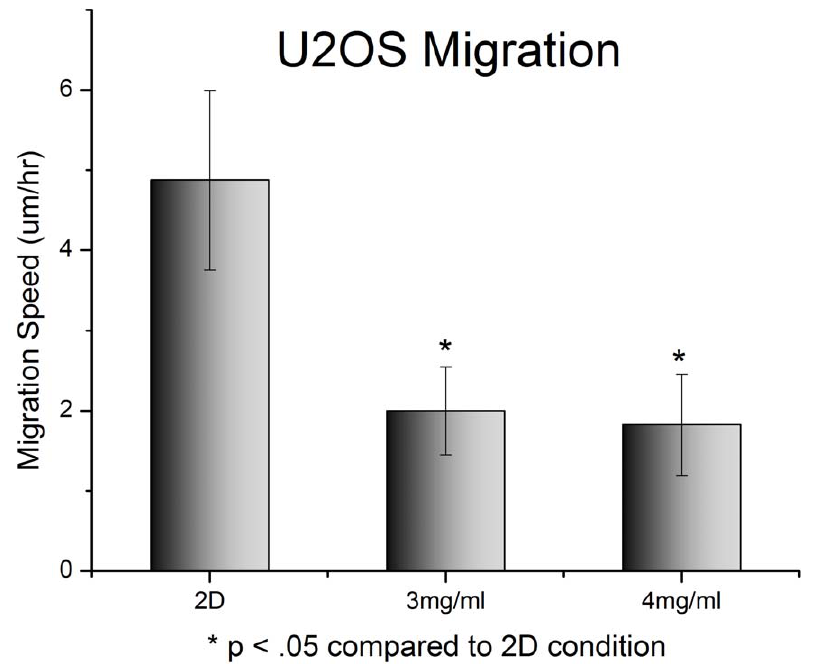
Figure 6. Migration of U2OS cells on standard 2D tissue culture plastic compared to 3D collagen gels. Cells were plated, and then immediately underwent timelapse imaging for 12 hours. Data here is the average speed of the cells over the course of the imaging sequence. Cell tracking was done using Imaris H software suite (Bitplane Inc., St. Paul, MN), with additional data processing done in MatLab H . Cells on tissue culture plastic moved 2.5 times fasters than cells grown in 3D collagen gels (p , .01).